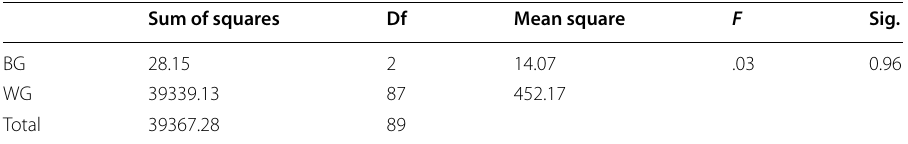
Table 17 Inferential statistics of anxiety pretest of all groups Sum of squares Df